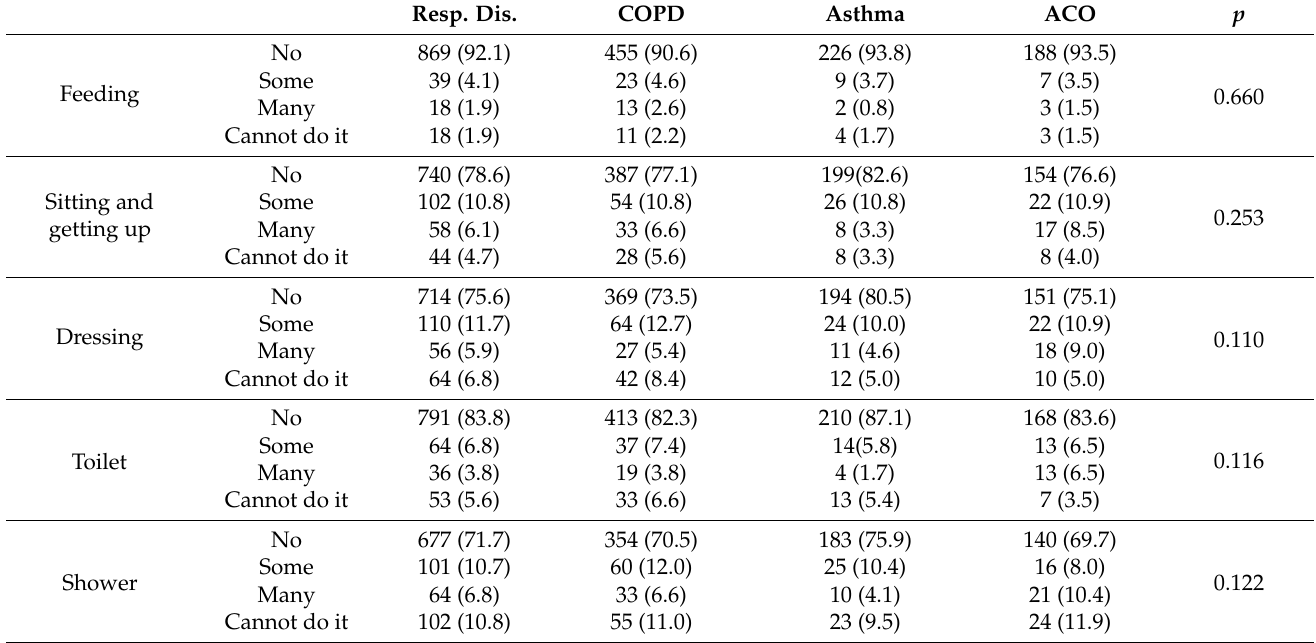
Table 2. Limitations to perform Basic Activities of Daily Living (BADL) in older adults with COPD, Asthma or ACO. Resp.